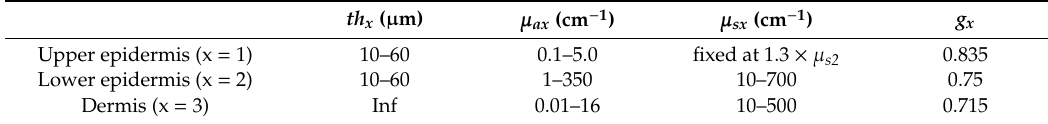
Table 1. Ranges of parameters used to generate the reflectance